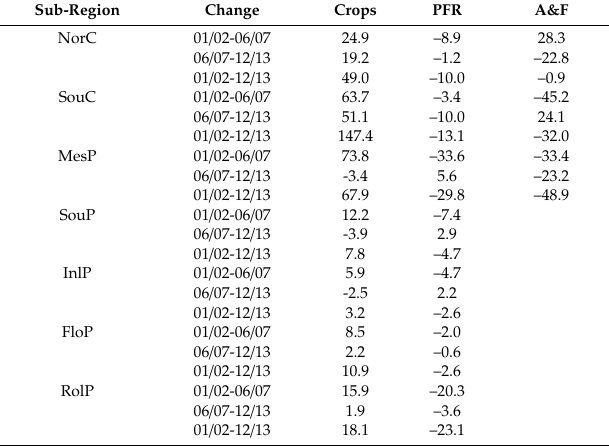
Table 7. Relative change, expressed as a percentage, on the surface of mapped categories for the different RPG sub-regions and for different periods of time. 01/02–06/07 represents the changes that occurred between 2001/2002 and 2006/2007. 06/07–12/13 represents the changes that occurred between